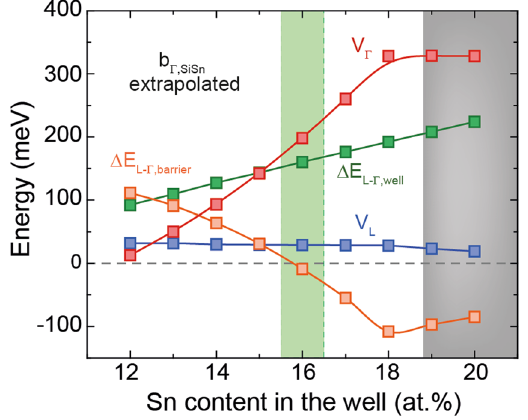
Figure 11. Recalculation of directness and highest band discontinuities of GeSn/SiGeSn heterostructures as presented in Fig. 3, but using the b Γ , SiSn behavior extrapolated from ref. 37